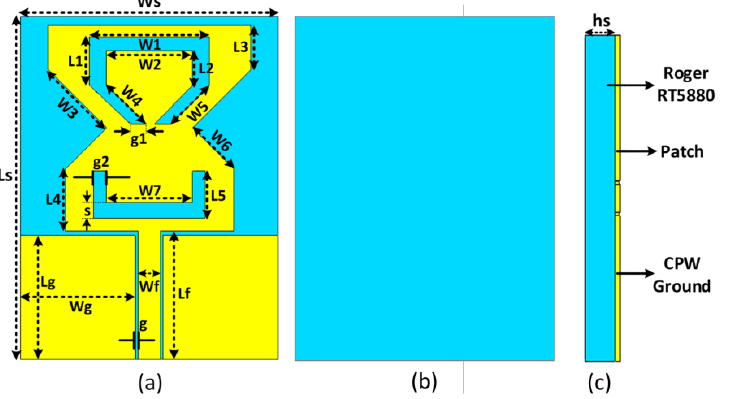
Figure 3. Microstrip feedline and an umbrella-shaped radiator comprise the antenna’s geometry; ( a ) front view, ( b ) back view, and ( c ) side view. Table 1. Optimized dimensions of the proposed design.